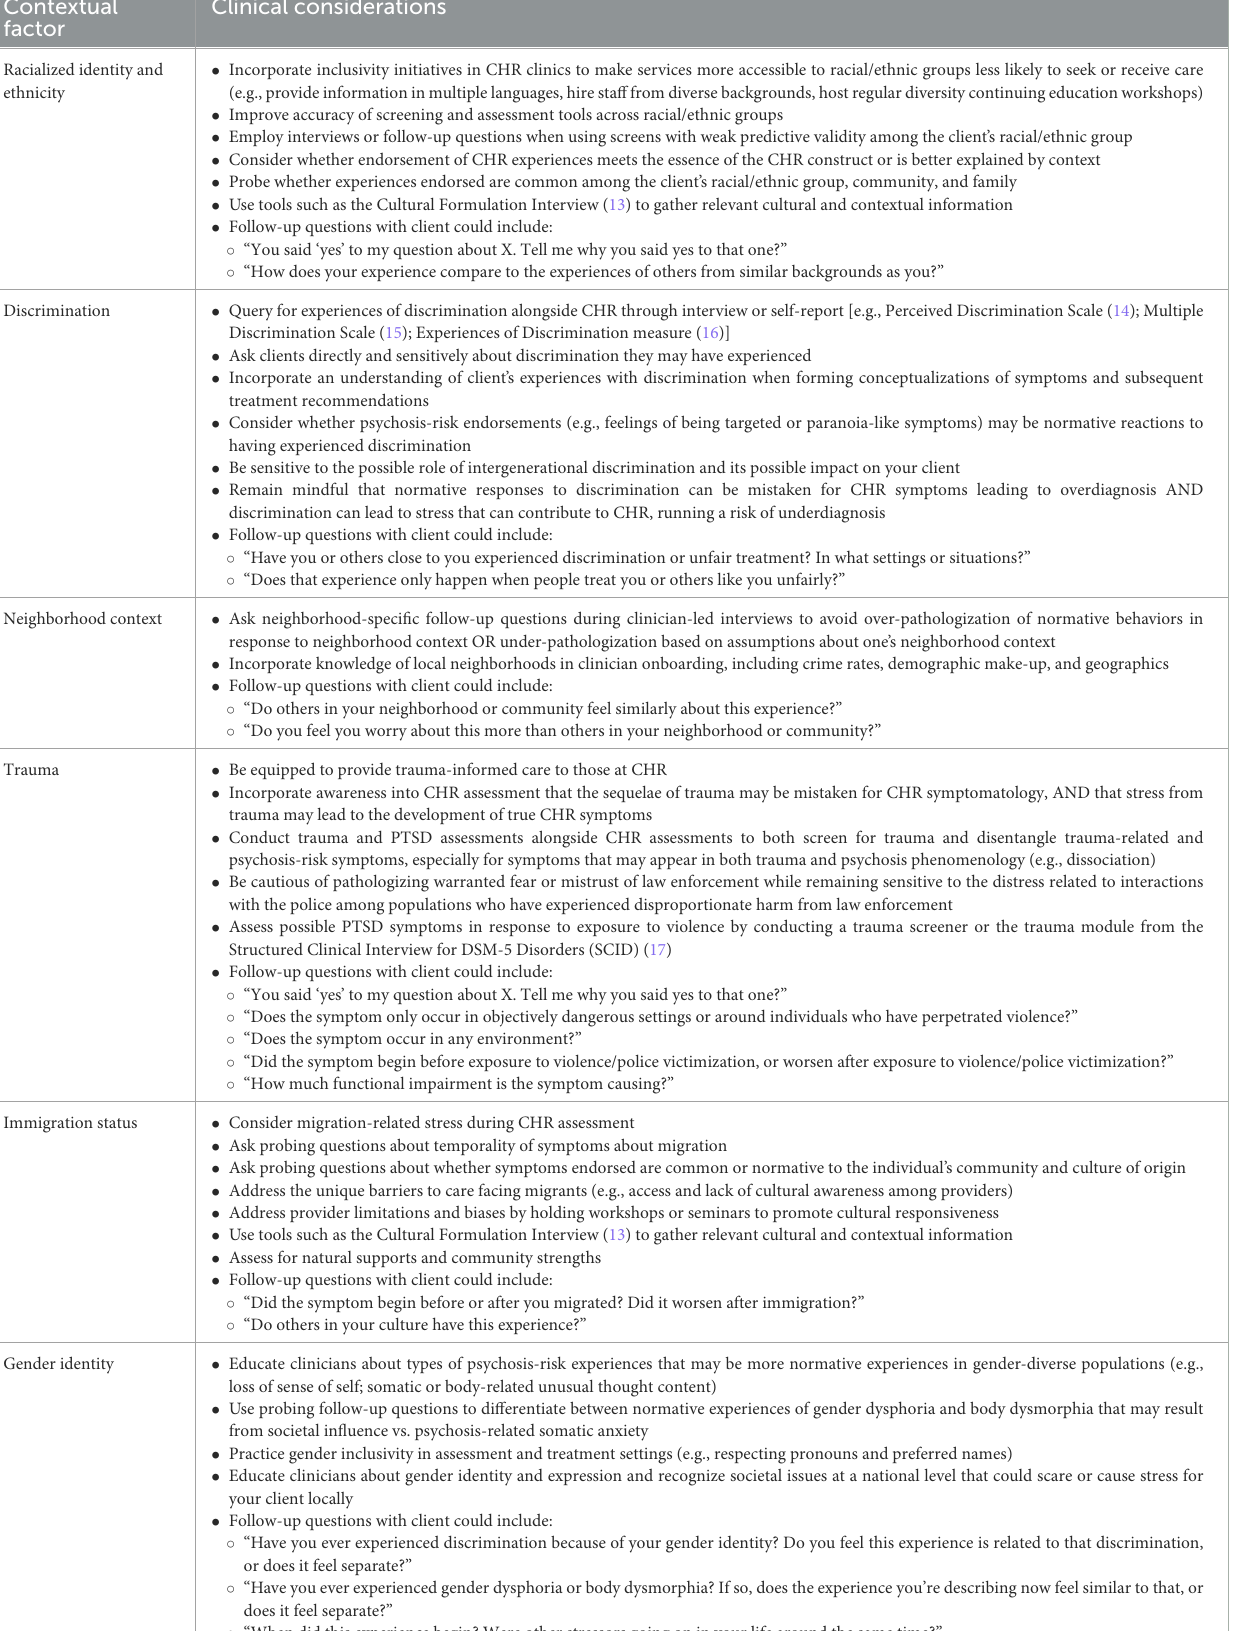
TABLE 1 Clinical considerations for each contextual factor